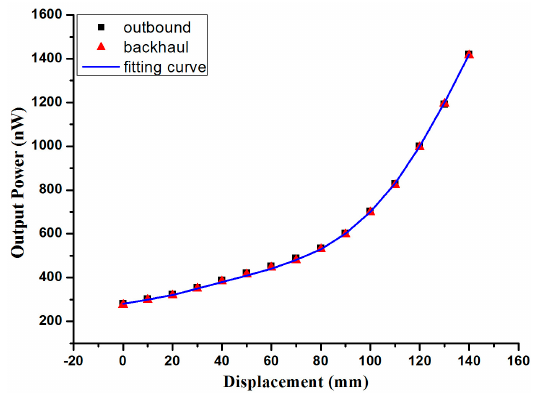
Figure 5. Output power of receiving fiber changes with displacement.